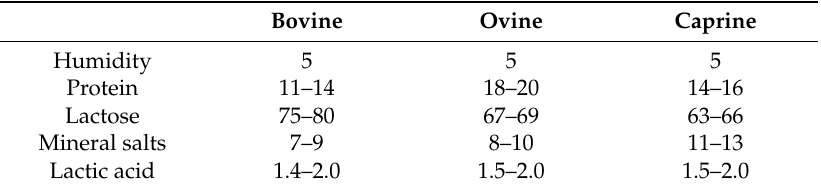
Table 9. Average composition of lactic serum in powder (in 100 g of substance).